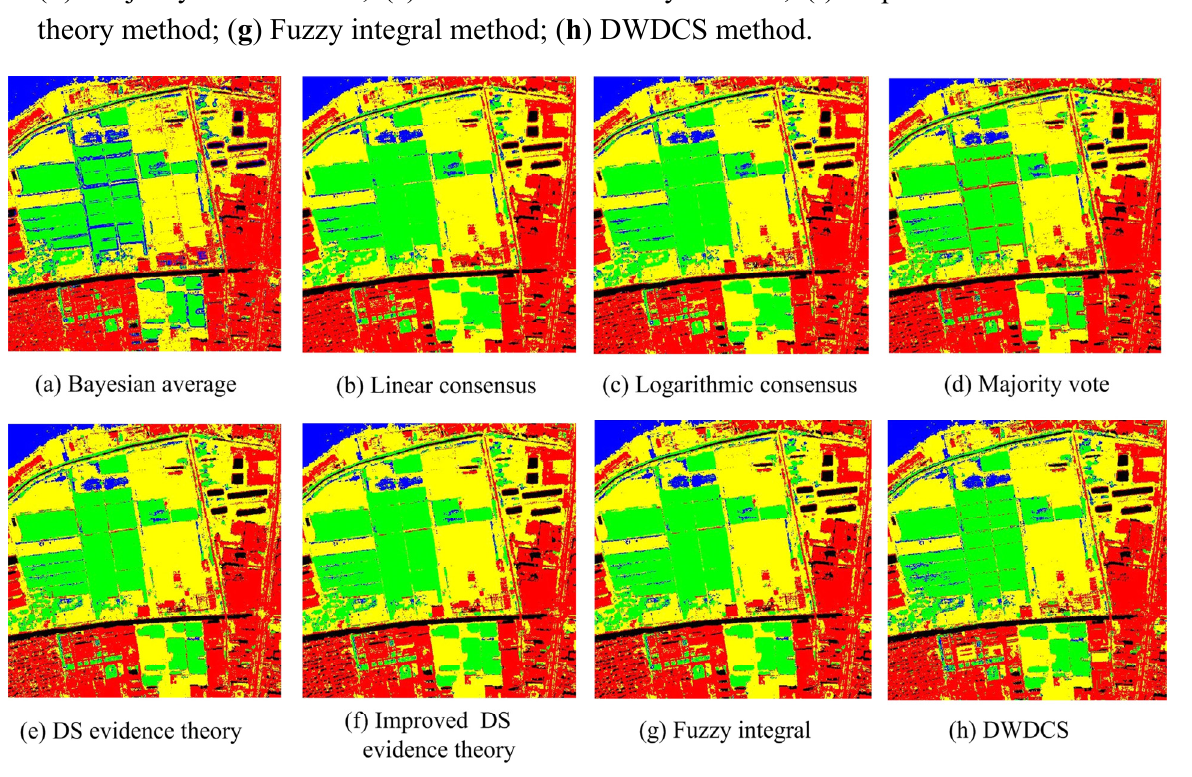
Figure 3. Classification results obtained by parallel combination approaches. ( a ) Bayesian